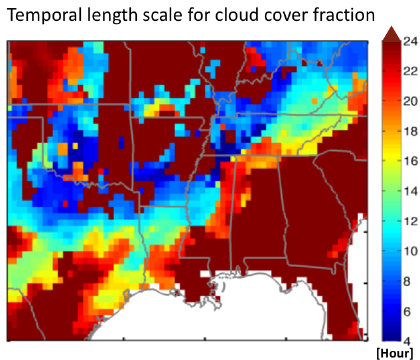
Figure 4. Persistence timescale for cloudy conditions in the GEOS- FP assimilated meteorological data for August–September 2013. The persistence timescale is defined as the temporal e -folding cor- relation timescale for total cloud cover fraction in the 3h GEOS-FP